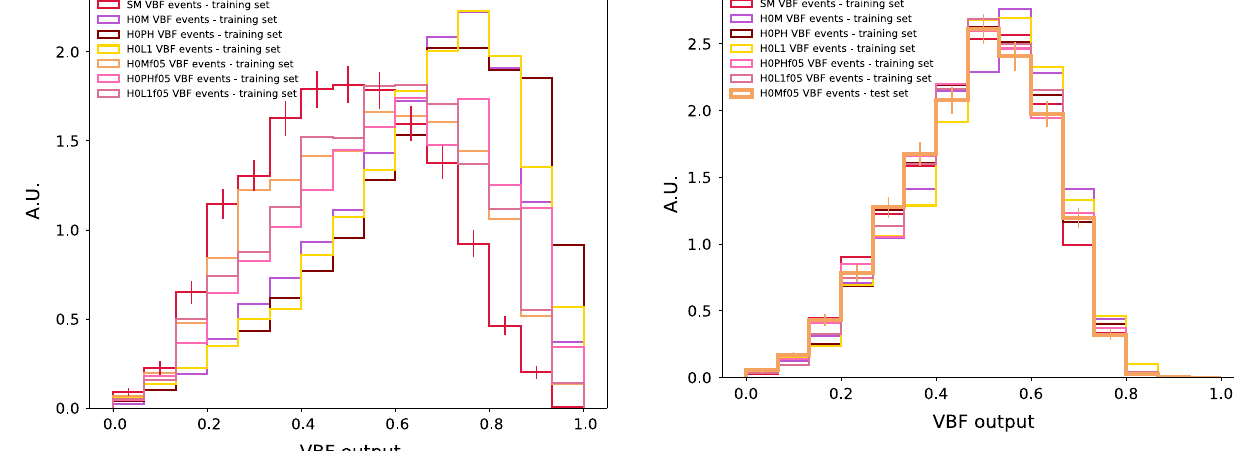
Fig. 10 Normalized distribution of the VBF-output of an ADNN trained excluding H0Mf05 in C1. The uncertainty associated with the limited size of simulated samples is reported only in the H0Mf05 dis-